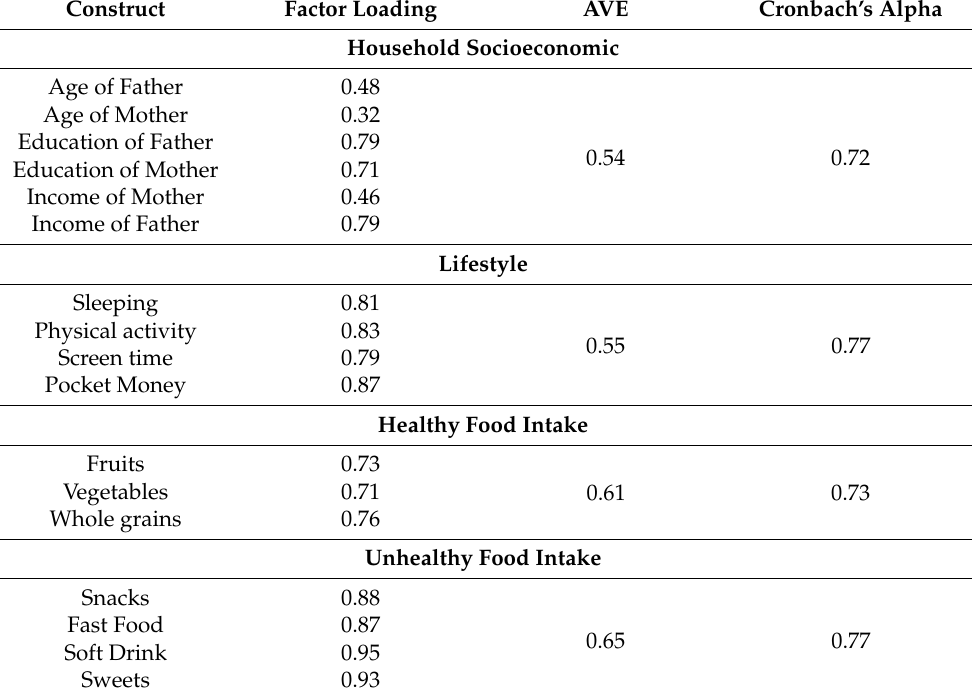
Table 3. Reliability and validity